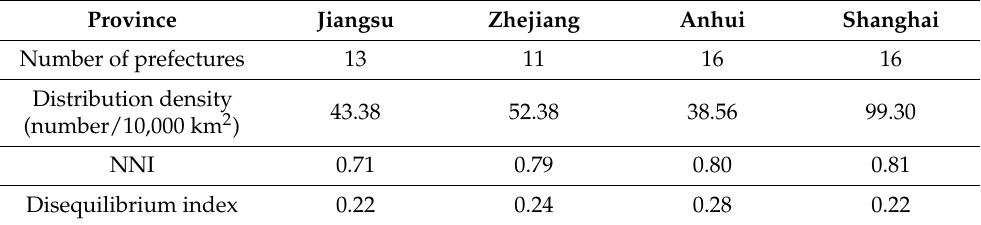
Table 2. The NNI and disequilibrium index of rural revitalization model villages in three provinces and one city in the